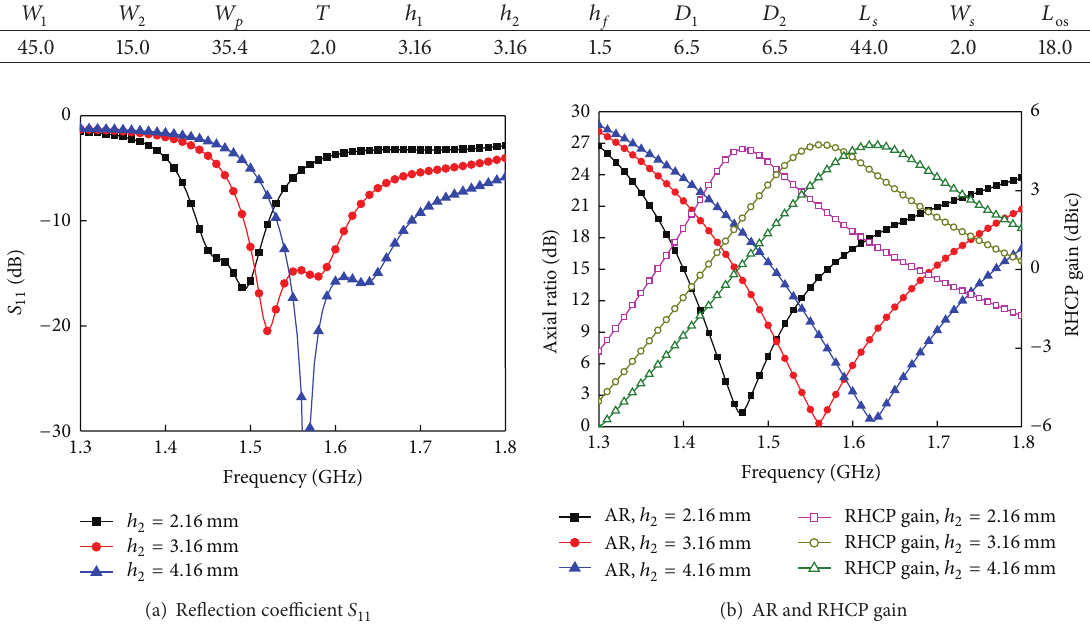
Figure 2: Effect of the aperture control part thickness h 2 on the reflection coefficient, gain, and axial ratio of the antenna.